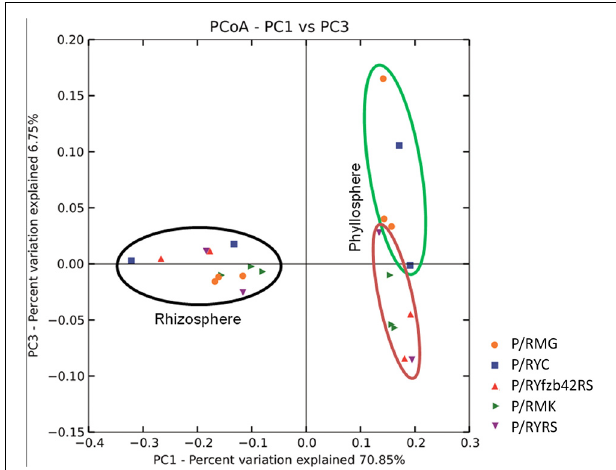
FIGURE 3 | Beta diversity metrics of bacterial 16S rRNA genes reveal distinctly clustered Gammaproteobacteria communities structured between healthy plants and plants affect by Rhizoctonia solani . Beta diversity community clustering is observed for phylogenetic beta diversity metrics (weighted UniFrac). In the panel, each point corresponds to a sample from either the lettuce rhizosphere (black) or the phyllosphere (green and red). Red—samples inoculated with R. solani; green—untreated control group. The percentage of variation explained by the plotted principal coordinates is indicated on the axes.